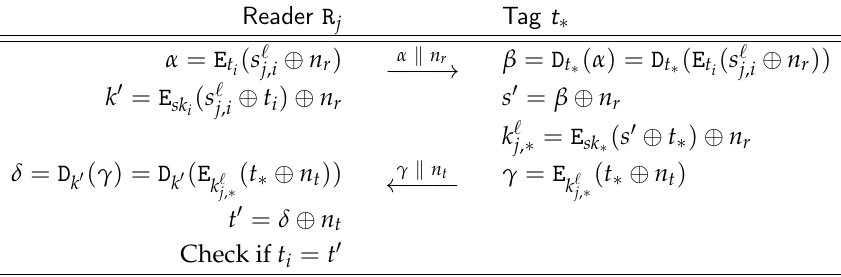
Figure 2. Tag Search Protocol.